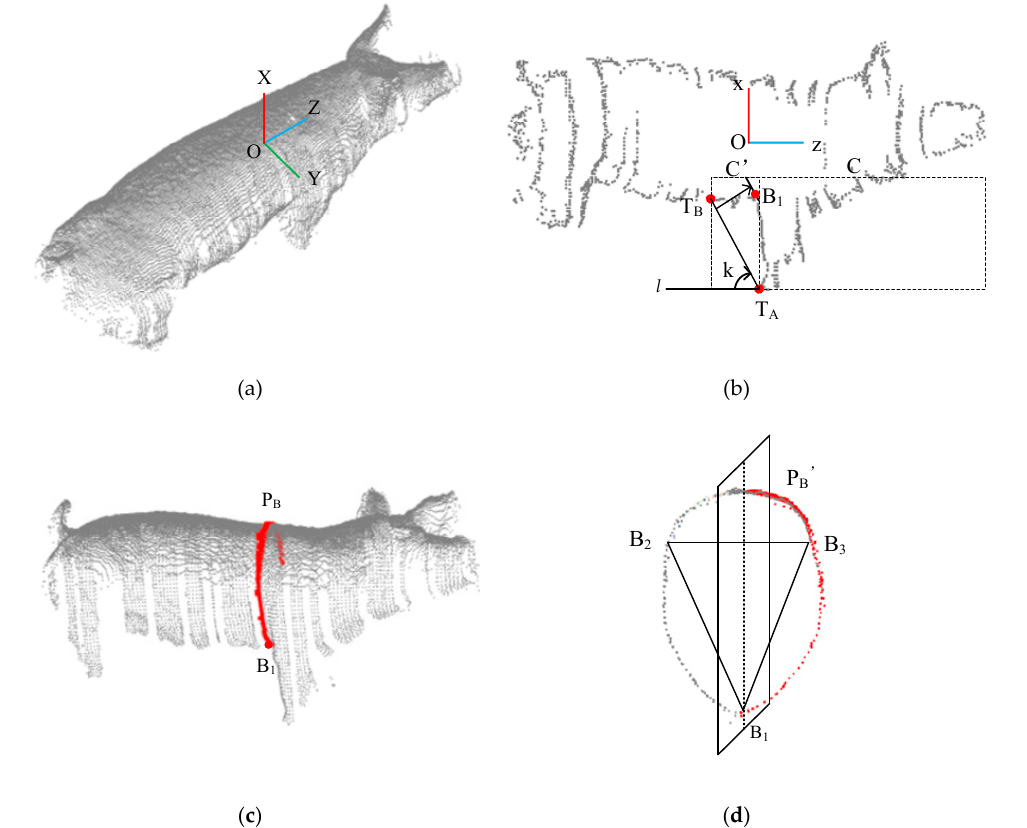
Figure 5. Heart girth measurement for a pig: ( a ) Pig point cloud after pose normalization; ( b ) Detection of the heart girth measurement point on the contour of the side-view point cloud; ( c ) The heart girth point cloud (red), which is obtained by taking the heart girth measurement point as the starting point and intercepting the circumferential perpendicular to the ground from the point cloud; ( d ) Application of mirror symmetry to obtain the whole heart girth point cloud, where the red points are those added to the point cloud through symmetrical filling.